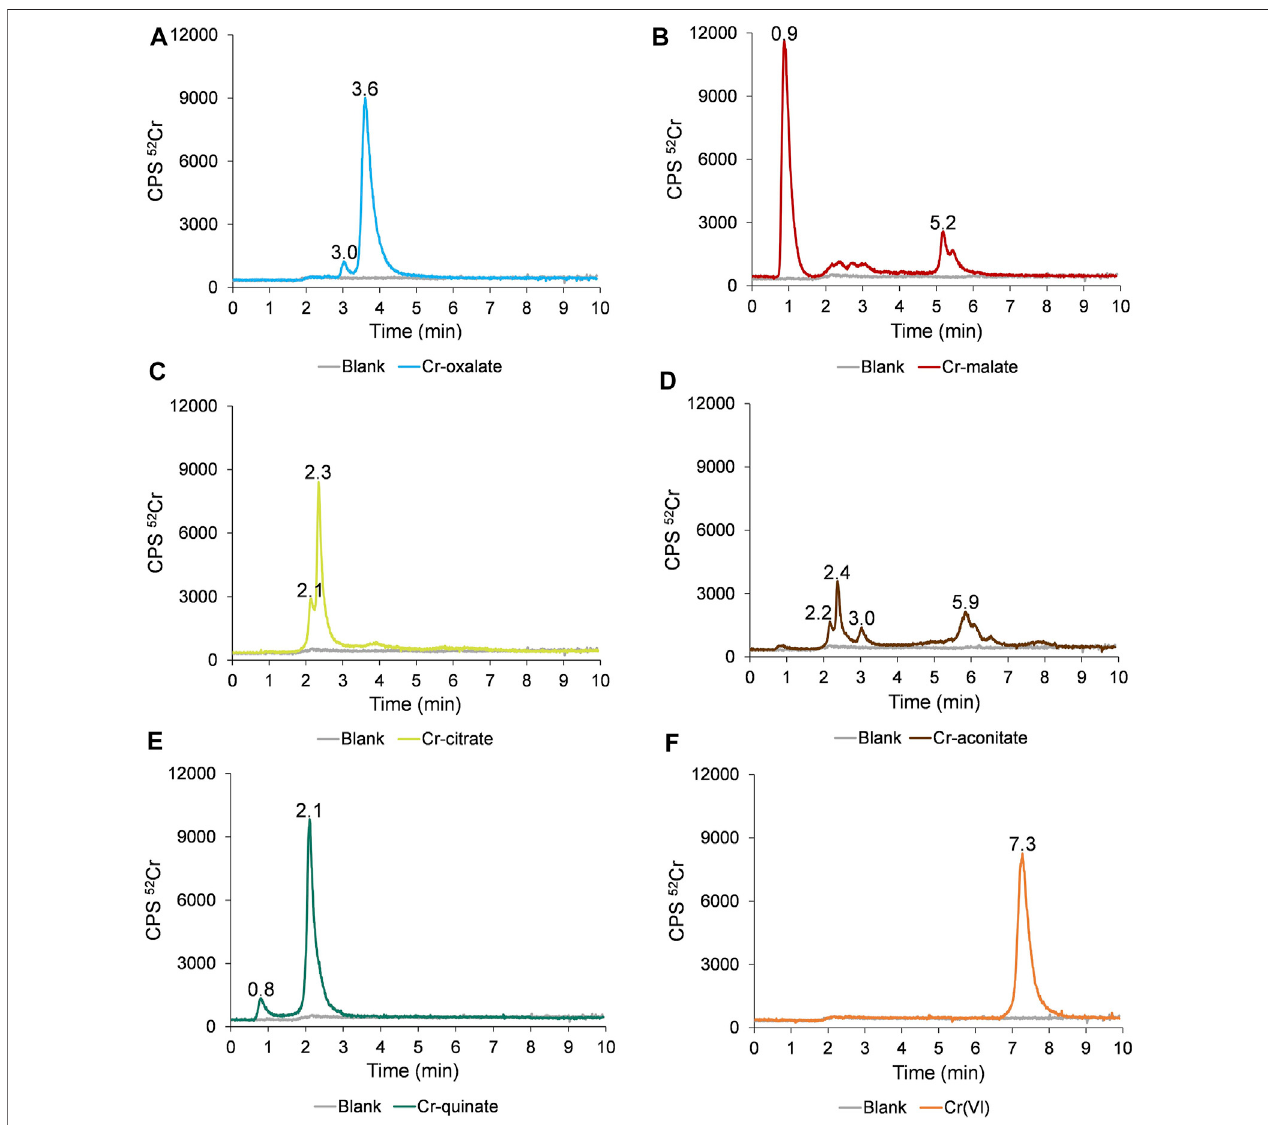
FIGURE 1 | Speciation of Cr in synthetic solutions of (A) Cr-oxalate, (B) Cr-malate, (C) Cr-citrate, (D) Cr-aconitate, (E) Cr-quinate, and (F) Cr(VI), containing 50 ng ml − 1 Cr, prepared in 0.013 mol l − 1 phosphate buffer (pH 6.5) applying the HPLC-ICP-MS procedure.